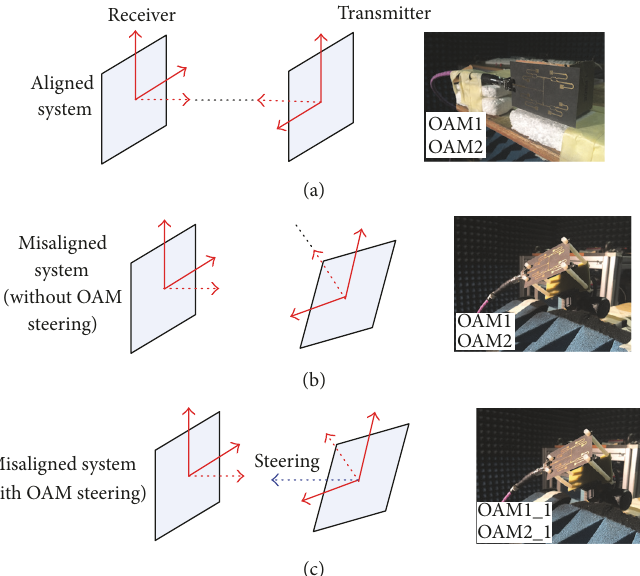
Figure 12: Experiment setup between the transmitter and receiver. (a) The aligned system, (b) misaligned system, and (c) misaligned system with twisted beam steering